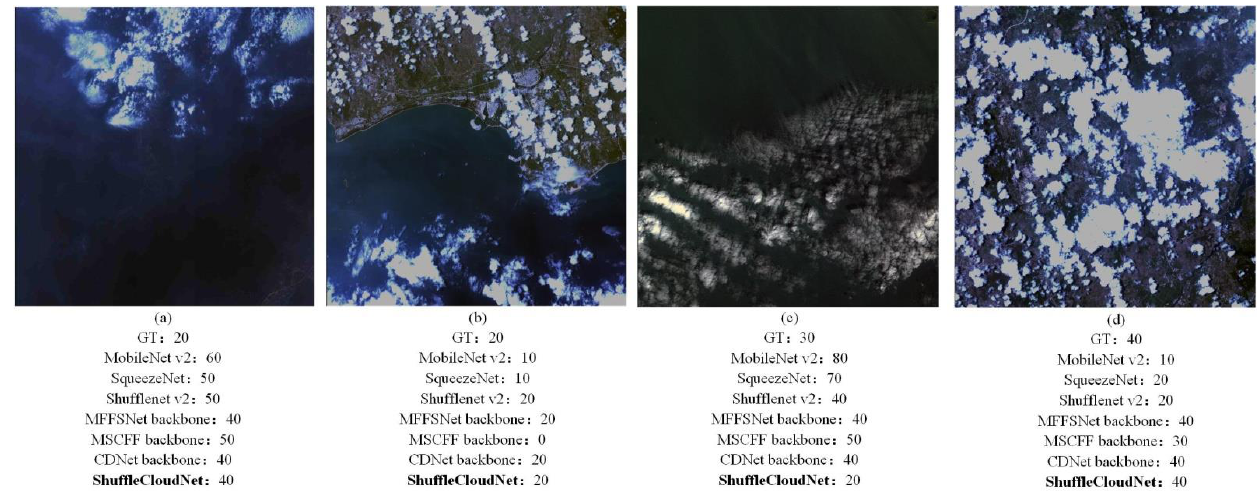
Figure 9. Test example diagram of AIR-CD dataset. ( a ) is an example of cloud amount calculation result of remote sensing image of thin cloud and thick cloud mixture. ( b ) is an example of the cloud amount calculation result of remote sensing image in the sea land scene. ( c ) is an example of the cloud amount calculation result of remote sensing image in the evening time. ( d ) is an example of cloud amount calculation result of remote sensing image of speckled cloud.